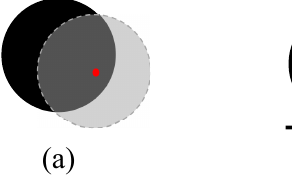
Figure 2. Drift correction was performed manually by the subject to have a centralized scotoma around the red dot at the beginning of each block. In the figure above, a hypothetical example of how a decentralized scotoma (in black) might look like ( a ) and hypothetical stages of position correction ( b , c ), black arrows, performed to have a concentric positioning of the scotoma around the red dot ( c ). The grey circle is used as a reference for this figure to indicate where the simulated scotoma should be positioned.